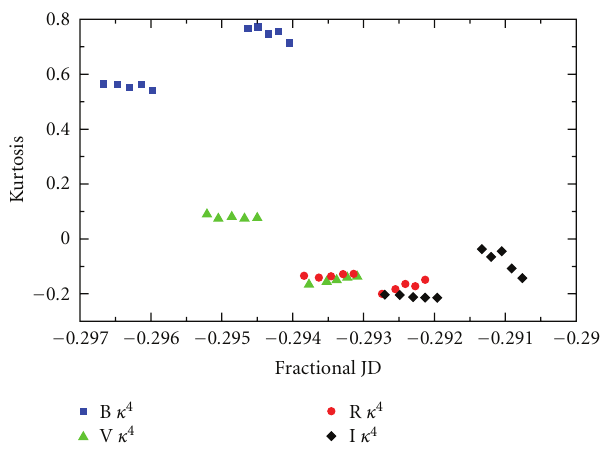
Figure 8: The kurtosis of the ADU statistics versus fractional JD of sky flats taken at the Mont Sec observatory during dusk twilight, five days apart. The di ff erent symbols refer to the di ff erent Johnson- Cousins filters B, V, R, and I. Within each night, the kurtosis stays remarkably constant, allowing for immediate identifications of flats a ff ected by cosmics or clouds. The kurtosis o ff set in the blue filters visible between the two nights is probably caused by di ff erent e ffi ciency in the light-straying process in Earths atmosphere.